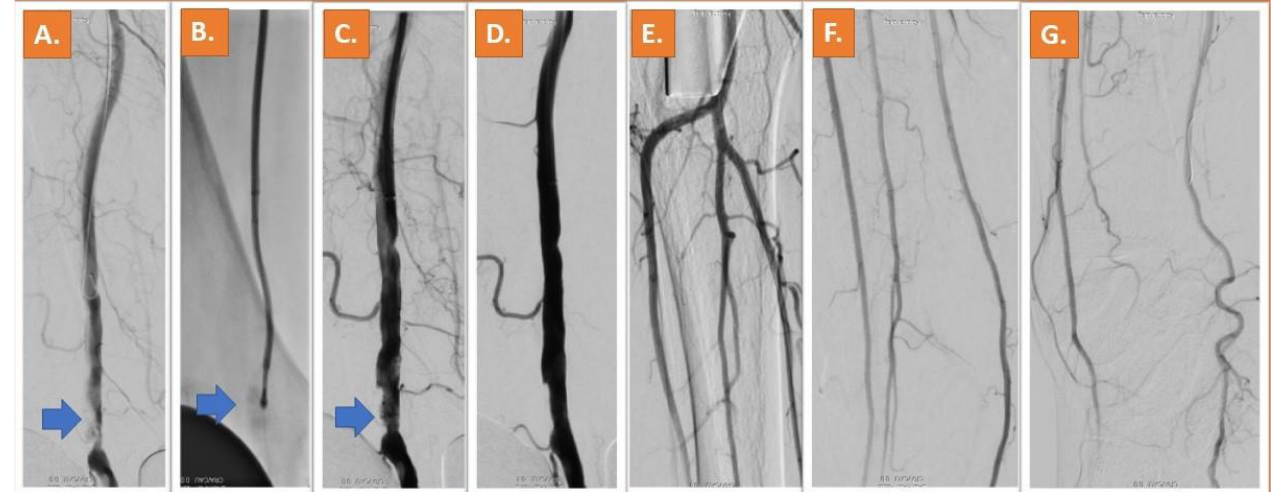
Figure 2. A calcified lesion in the P1 segment of the popliteal artery can be depicted in ( A ) (blue arrow), in a female 81 years old patient with lifestyle limiting claudication (RC4). After 2.4 mm de- flecting Phoenix atherectomy ( B ), significant lumen gain is obtained ( C ). The result after atherec- tomy and DCB including the perfusion of the peripheral vessels can be appreciated in ( D – G ) [11].